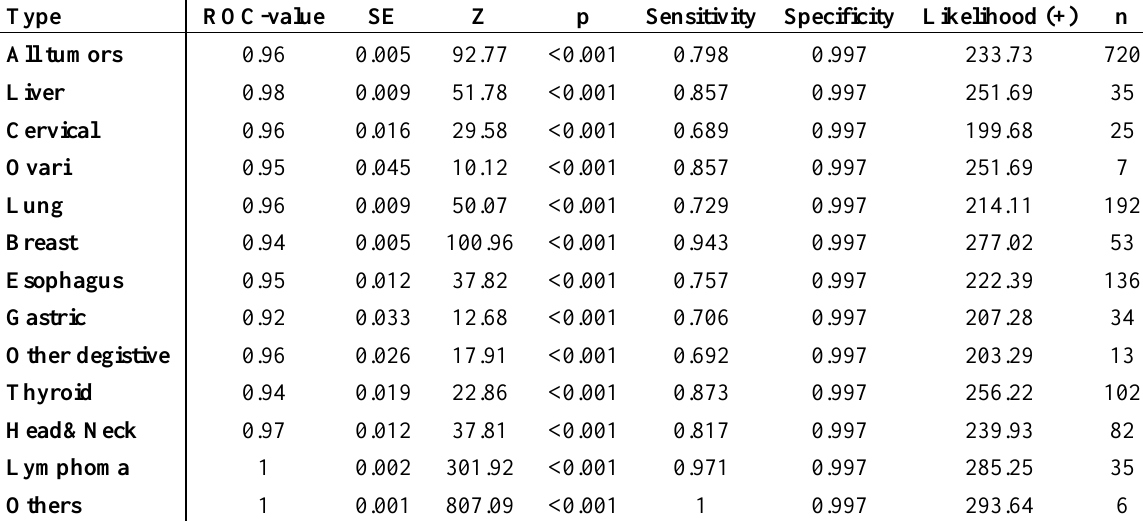
Table 2. Receiver operation characteristic (ROC) characterization of patients (n = 720) with various types of tumours in relation to healthy people and people with different types of illnesses (total n = 4,103), except for people with pre-malignant and malignant diseases.